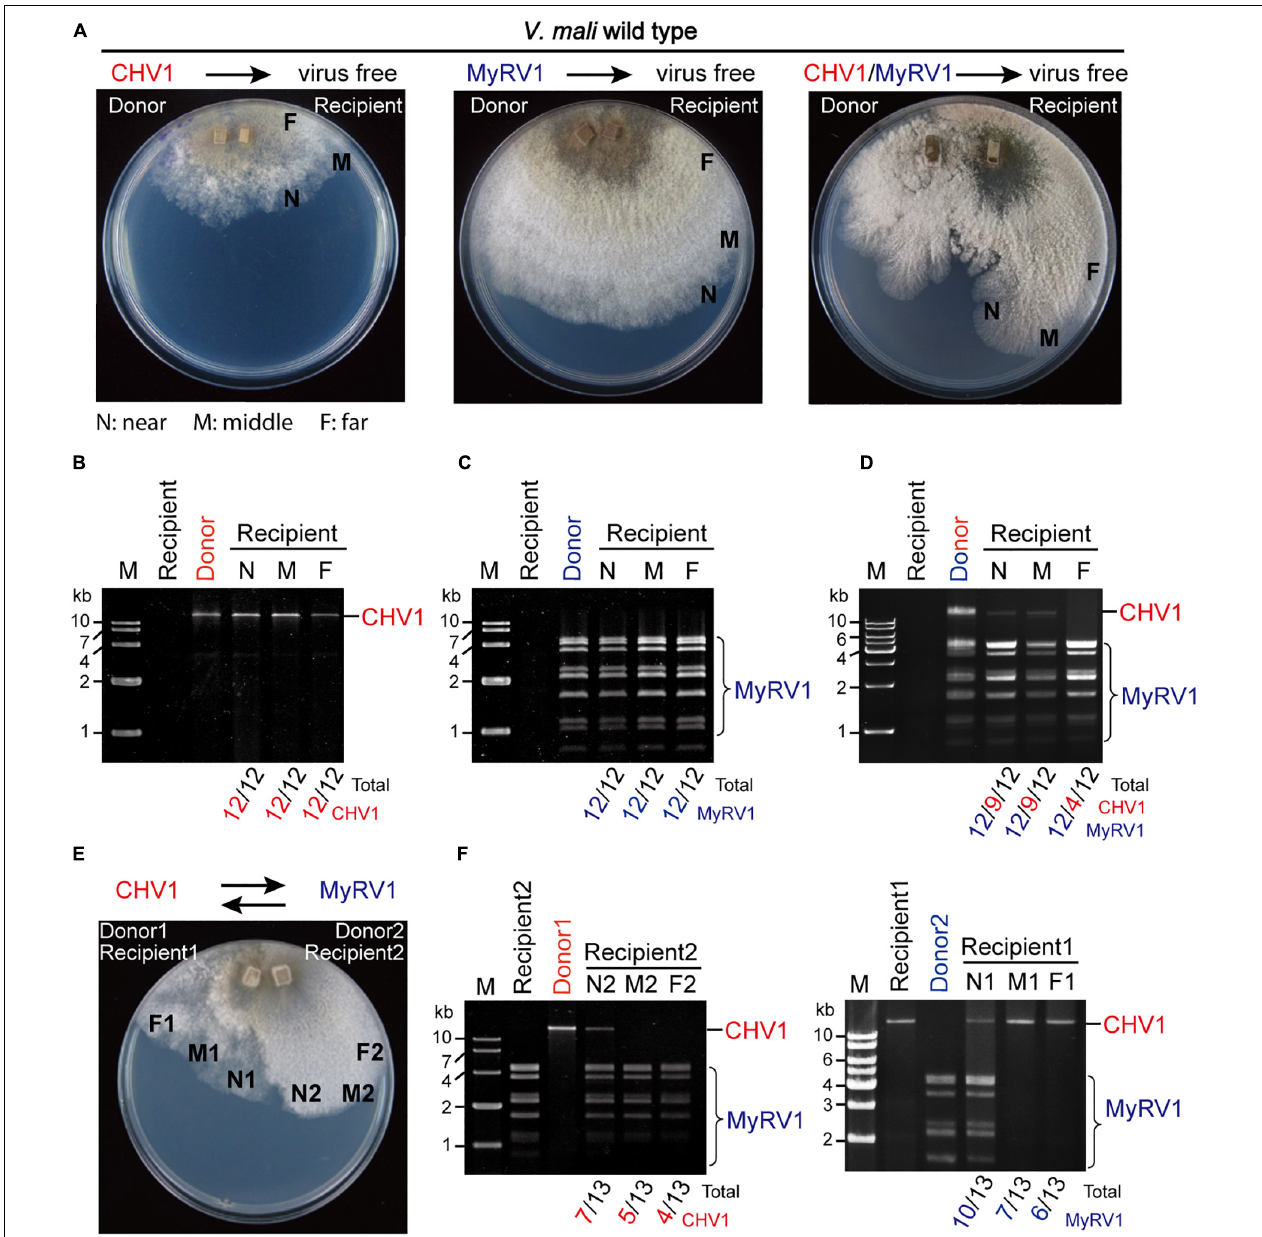
FIGURE 4 | The efficiency of CHV1 and MyRV1 horizontal transmission via hyphal anastomosis in V. mali . (A) Co-culture on PDA plates of the virus-free V. mali strain and the virus-infected V. mali strain as recipient and donor viruses, respectively. After 1 week of hyphal contact, mycelial plugs were removed from three locations (a near, middle, and far distance from the hyphal fusion areas) in the recipient side, transferred onto new PDA plates and cultured in PDB for dsRNA extraction. (B–D) Detection of viral dsRNAs in recipient strains co-cultured with CHV1-infected (B) , MyRV1-infected (C) , and CHV1 + MyRV1-infected strains (D) . The numbers below the lanes indicate the number of samples in which viral dsRNAs were detected per total number of samples. (E) Co-culture of CHV1-infected and MyRV1-infected V. mali strains on a PDA plate. After 1 week of hyphal contact, mycelial plugs were removed from three locations on both sides, transferred onto new PDA plates and cultured in PDB for dsRNA extraction. (F) Detection of viral dsRNAs in fungal strains obtained in the co-culture experiment described in (E)